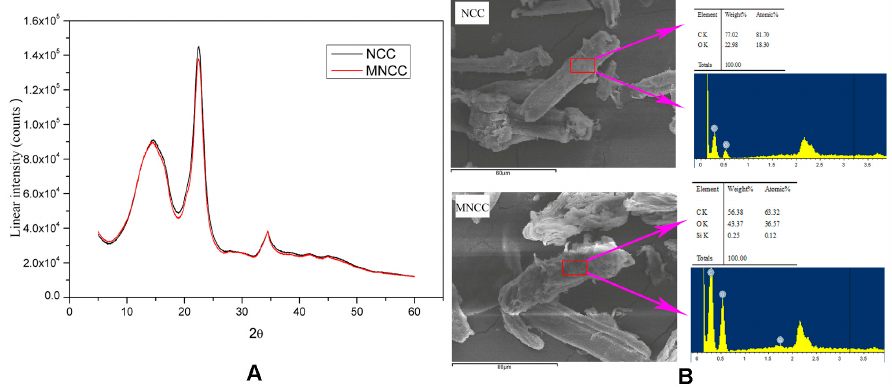
Figure 1. X-ray diffraction patterns ( A ) and EDS analysis ( B ) of NCC and MNCC.